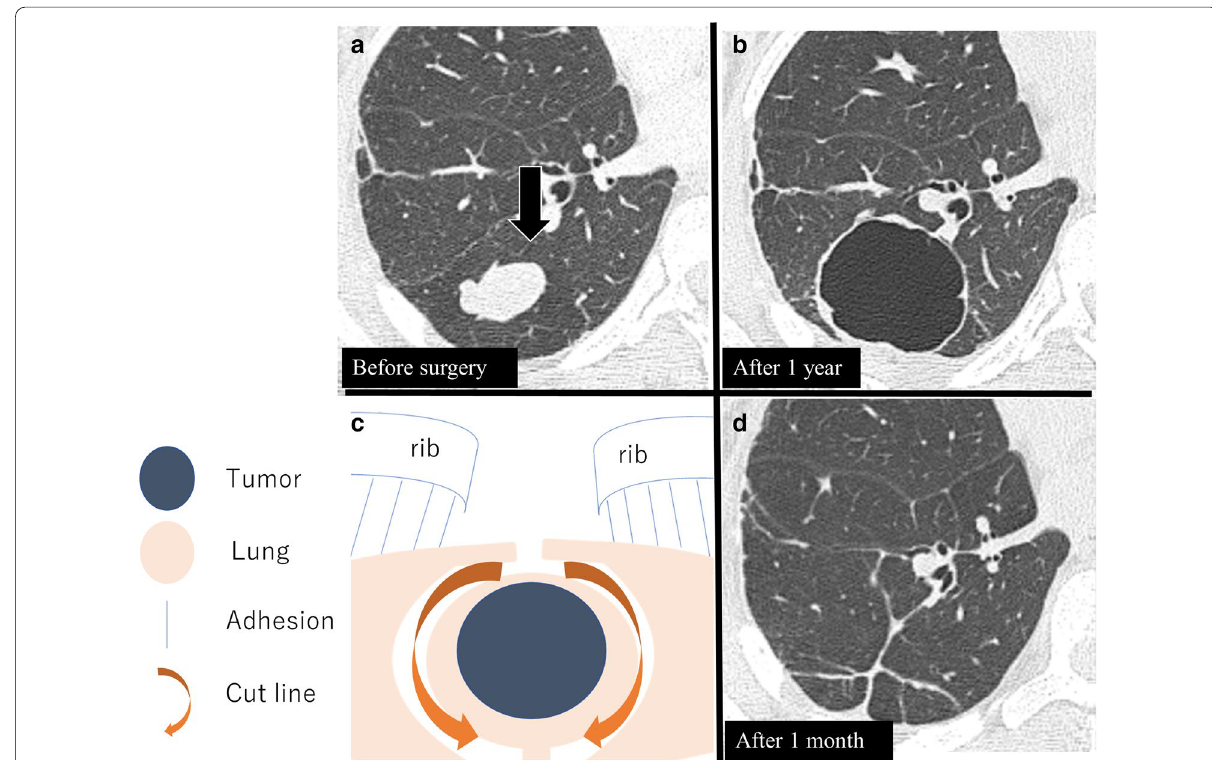
Fig. 3 Pretreatment approach for metastatic lesions. Computed tomography revealing a deep pulmonary lesion (arrows), which is treated using radiofrequency ablation ( a ). Radiation therapy is performed for a lesion near the aortic arch (black arrowhead) and pulmonary artery (yellow arrowhead) ( b